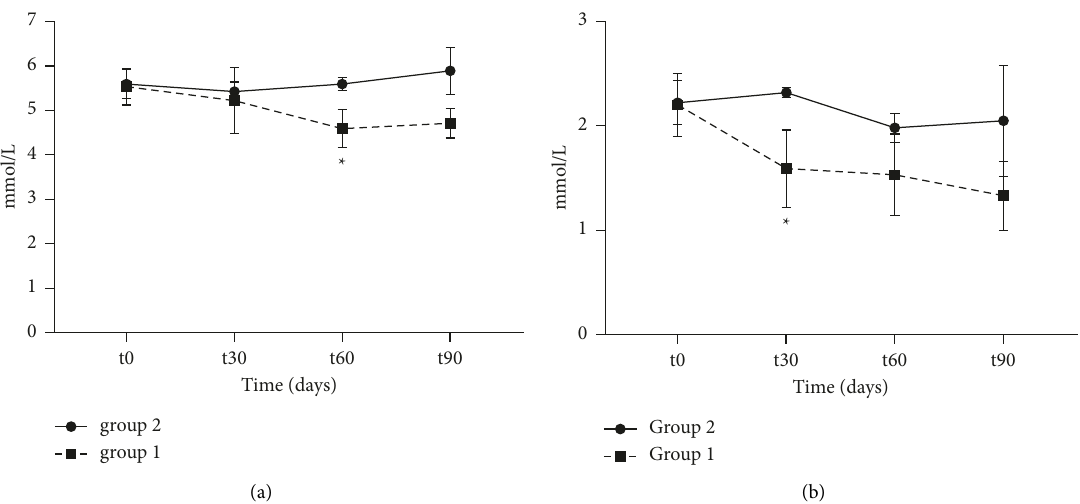
Figure 4: Effect of camel milk on cholesterol (a) and TG (b) levels.